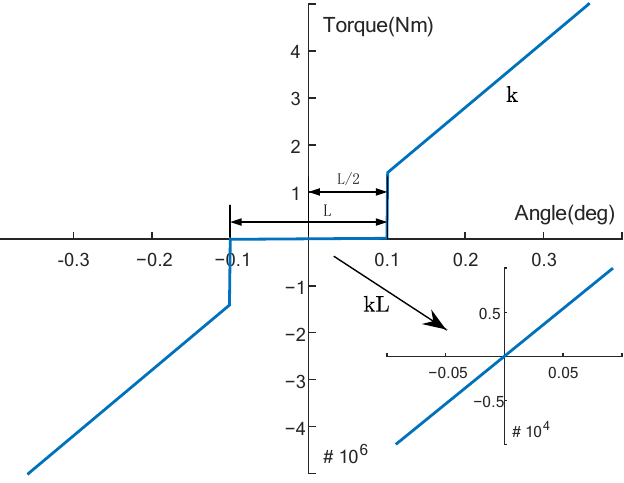
Figure 4. The joint stiffness of the CMM.